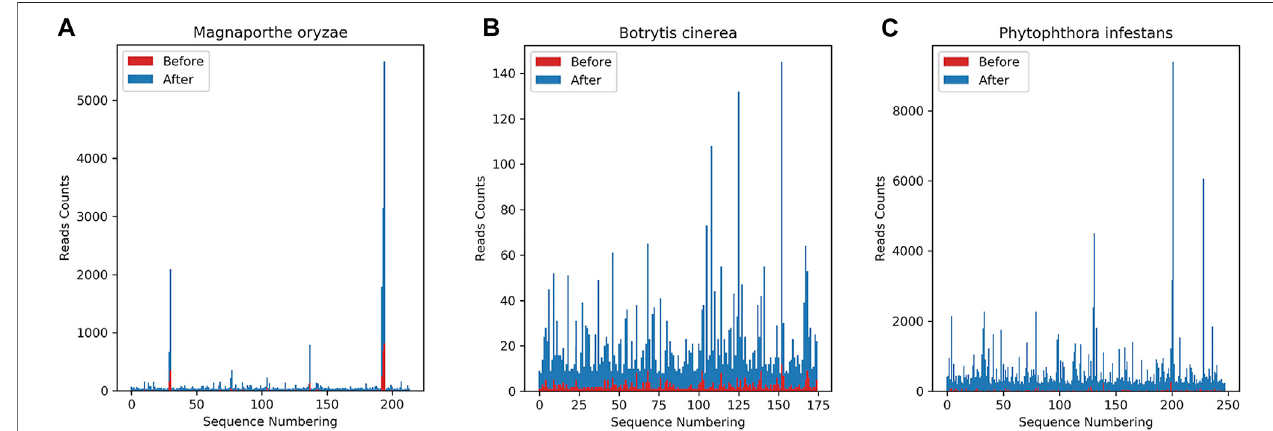
FIGURE 5 | Differences in sRNA expression levels co-existing before and after infection. The abscissa is the sequence index, sorted according to the sequence dictionary order, and the ordinate is the amount of expression. Red indicates the expression level before fungus infection, and blue indicates the corresponding